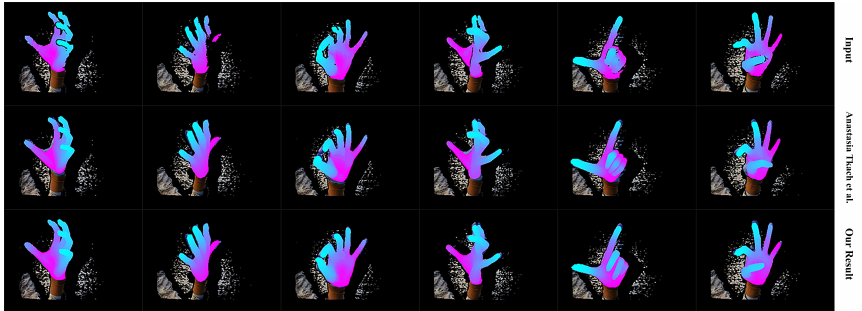
Figure 26. The qualitative comparison between our system with Tkach et al. [5] on Handy/Teaser. The upper row shows the hand segment of the input depth after pseudo-color enhancement; the middle row shows the rendered depth image from the recovered hand model of Tkach et al. [5]; the bottom row shows the rendered depth image from the recovered hand model of our system after pseudo-color